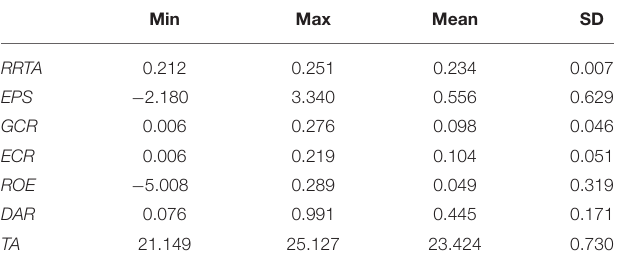
TABLE 2 | Descriptive statistics.